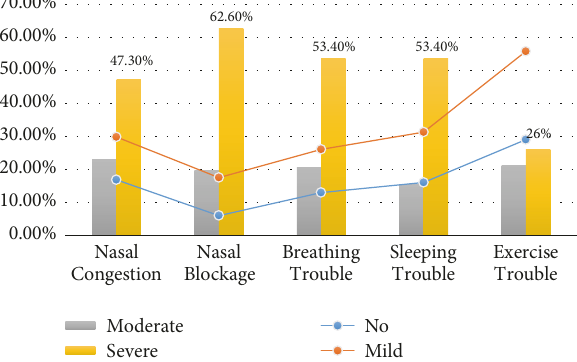
Figure 3: Description of patients by initial clinical